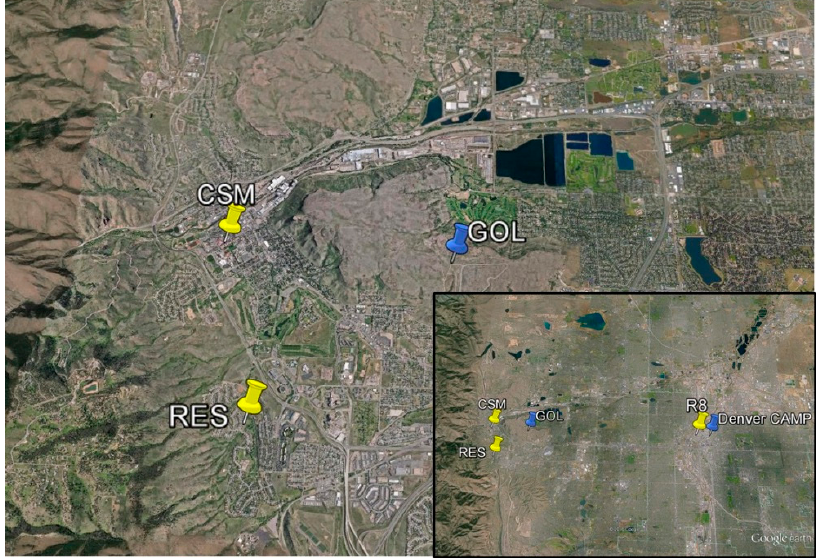
Figure 3. Map of the performance evaluation and citizen science sites in the Denver campaign.